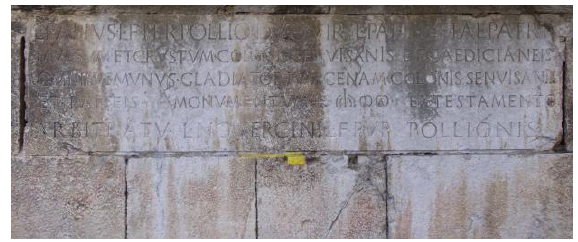
Figure 7. Orthophoto’s inscription